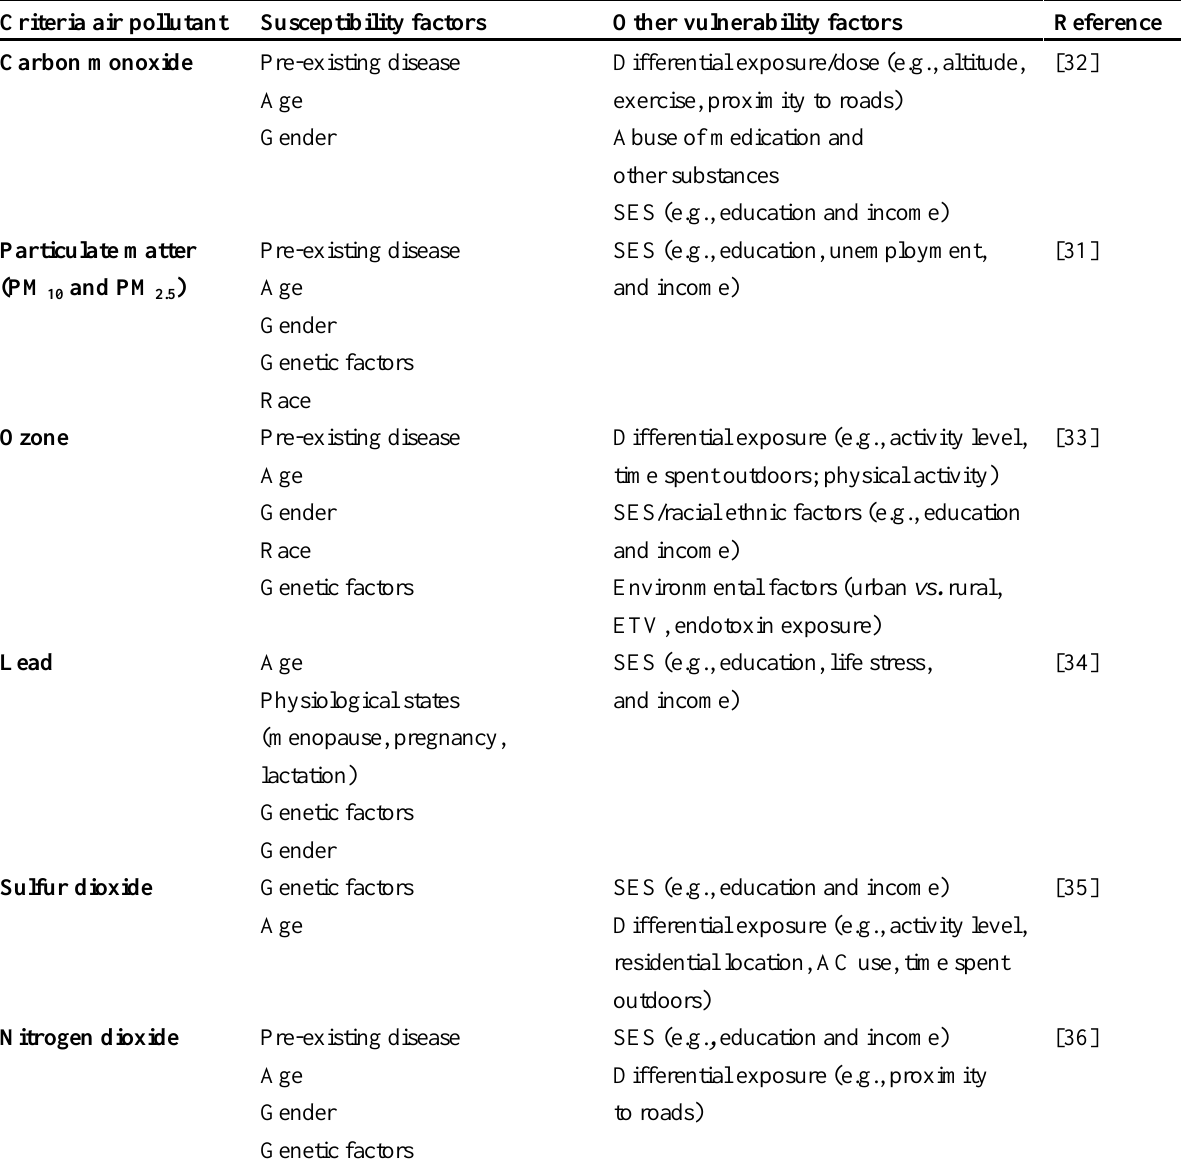
Table 1. Susceptibility and vulnerability factors considered for evaluation of the criteria air